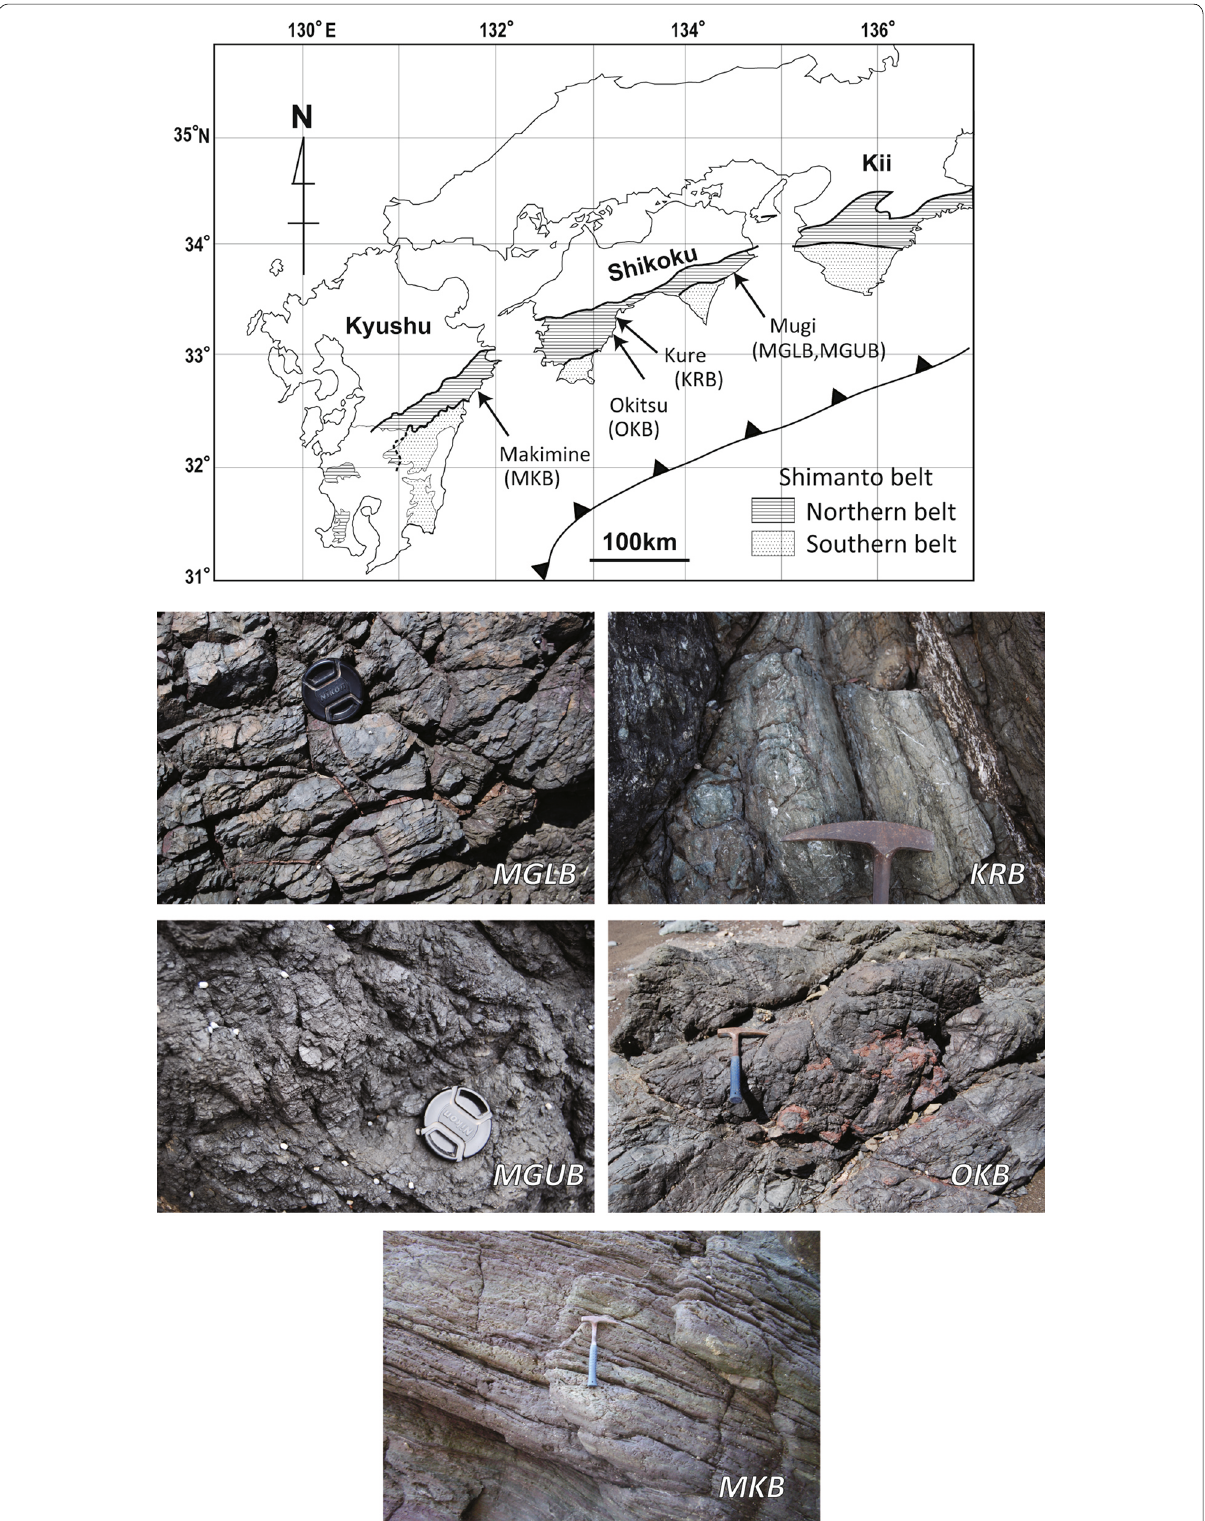
Fig. 1 Geological map of the Shimanto Belt in southwest Japan, showing the localities of mélange units that were sampled during this study and photographs of each sampling